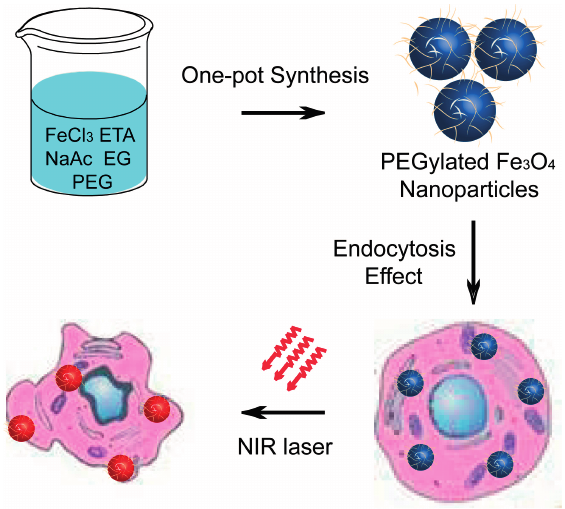
Figure 1. Schematic illustration of the synthesis of PEGylated Fe 3 O 4 nanoparticles and their application as photothermal agents for cancer therapy under near-infrared (NIR) laser irradiation.